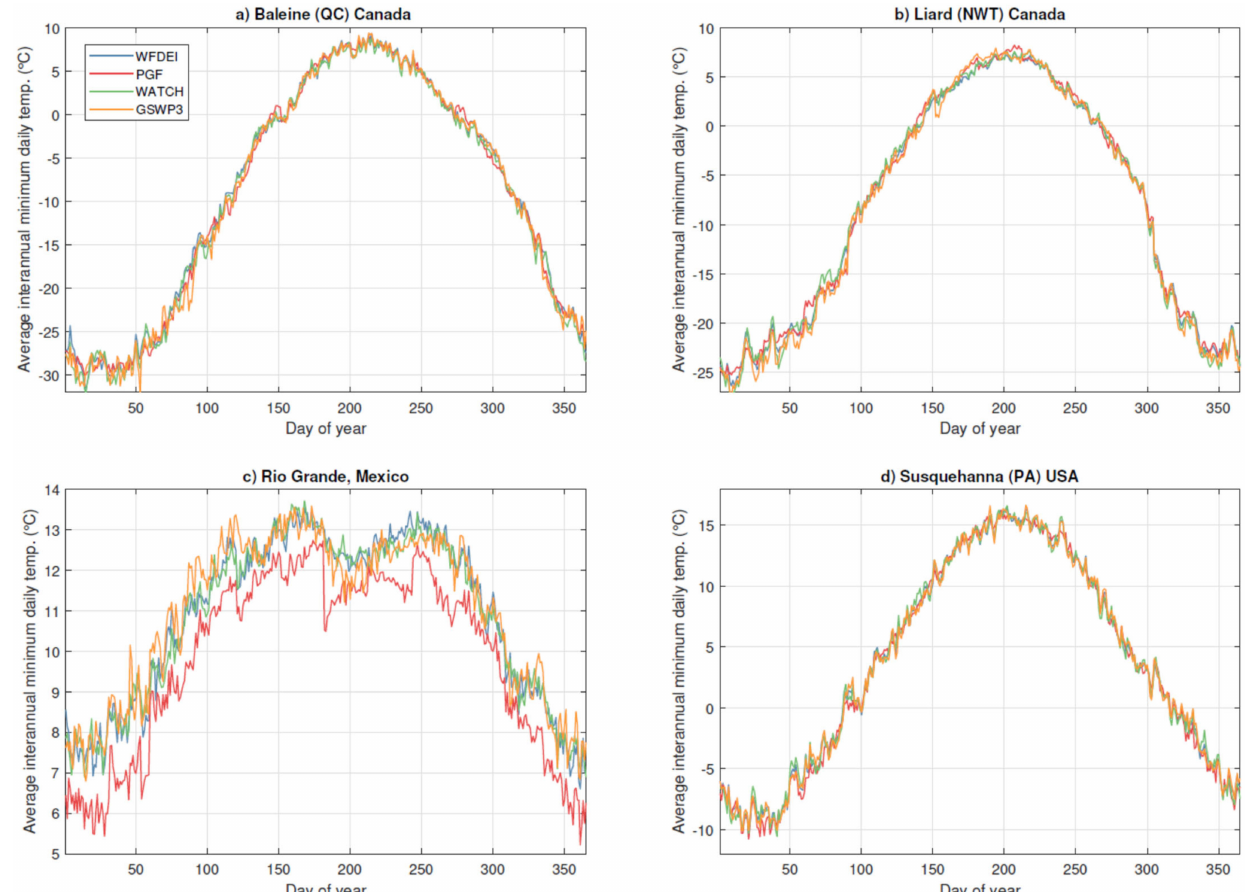
Figure 8. Average interannual minimum daily temperature from the four global meteorological datasets (WFDEI, Princeton PGMFD, WATCH, and GSWP3) over the ( a ) Baleine, ( b ) Liard, ( c ) Rio Grande, and ( d ) Susquehanna river basins over the 1971–2010